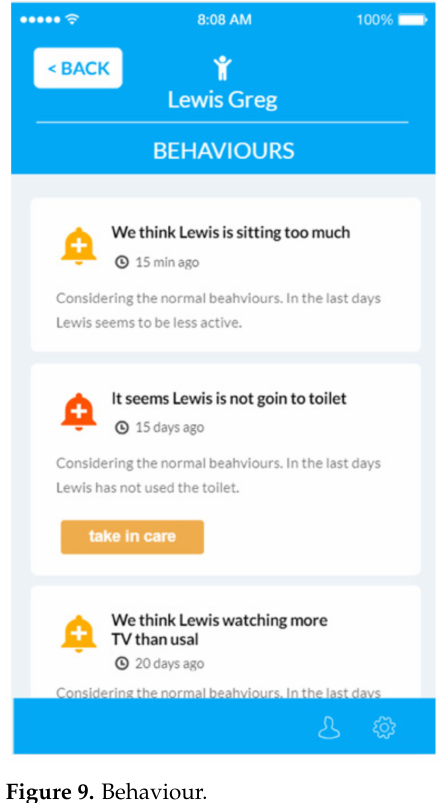
Figure 9. Behaviour.